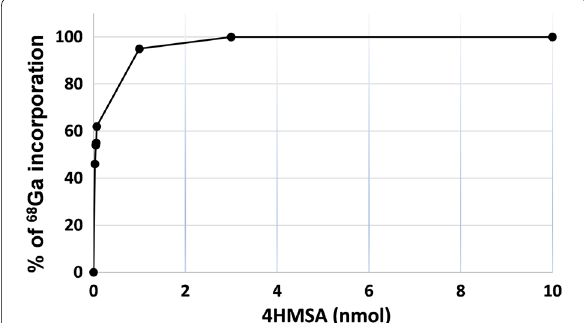
Fig. 2 Percentage of 68 Ga incorporation as a function of the 4HMSA concentration (nmol)